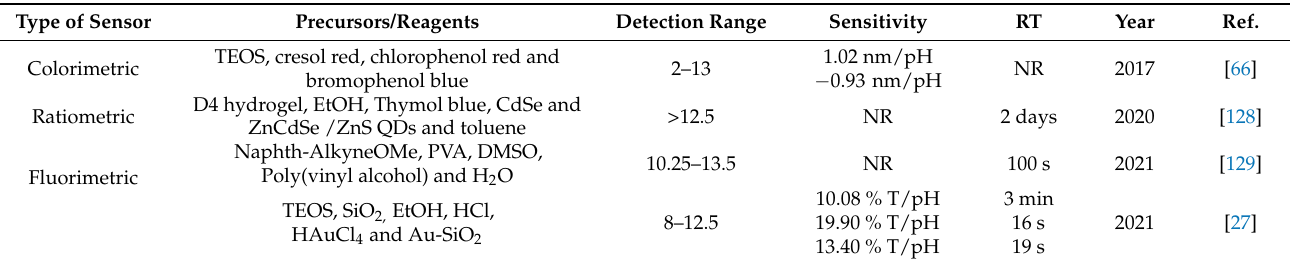
Table 1. pH sensors applied to